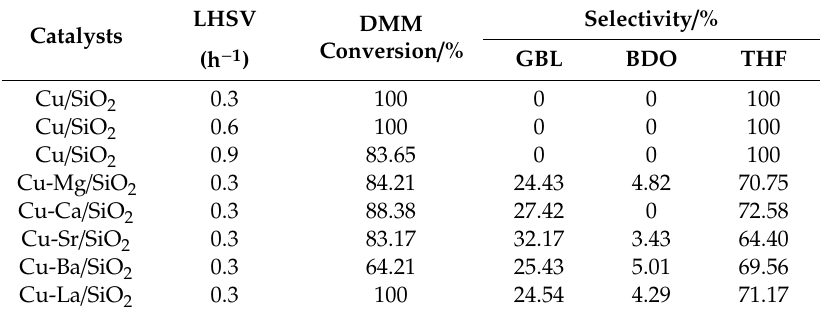
Table 2. The catalytic performances of Cu / SiO 2 and Cu-M / SiO 2 catalysts in hydrogenation of DMM. Catalysts